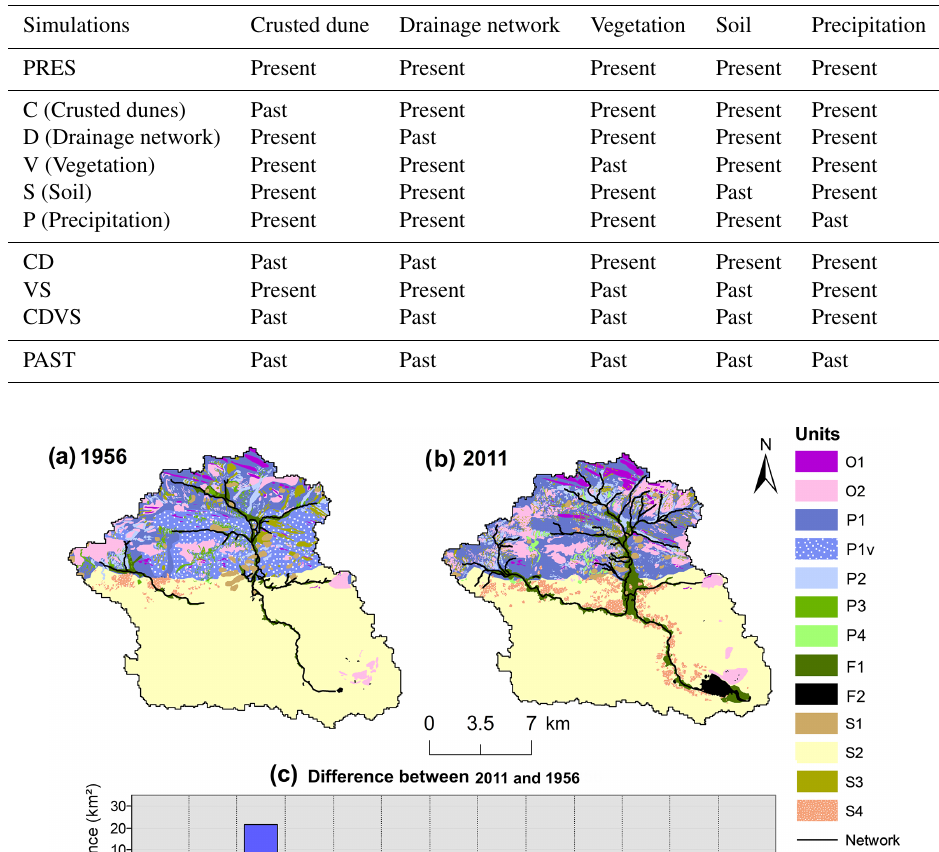
Table 5. Description of the simulations (first column) and associated forcing (second to fifth column) for the crusted dunes, the development of the drainage network, the evolution of the vegetation cover and soils and the change in the daily precipitation regime.